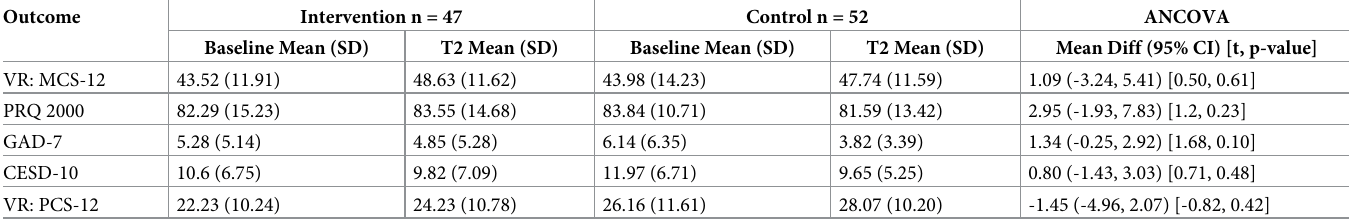
Table 3. Group differences in outcomes from baseline to six-months (n =